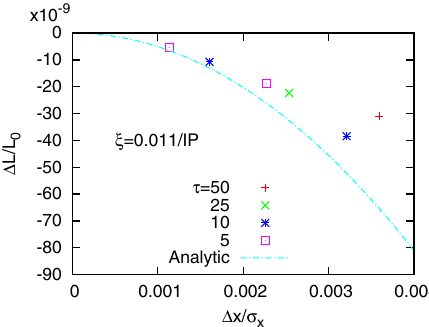
FIG. 20. Luminosity decrement as a function of the offset-noise amplitude. Results from a 2-dimensional strong-strong simula- tion (plotting symbols) are compared with predictions from Eq. (38), for the working point ð ν x ; ν y Þ ¼ ð 0 . 31 ; 0 . 32 Þ . The simulation is performed in 10 6 turns with the macroparticle number 10 6 .